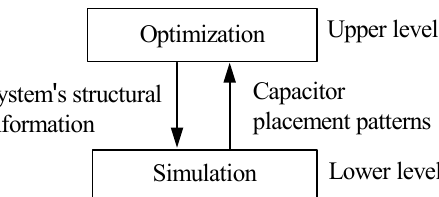
Figure 1. The framework of the ordinal optimization-based approach.